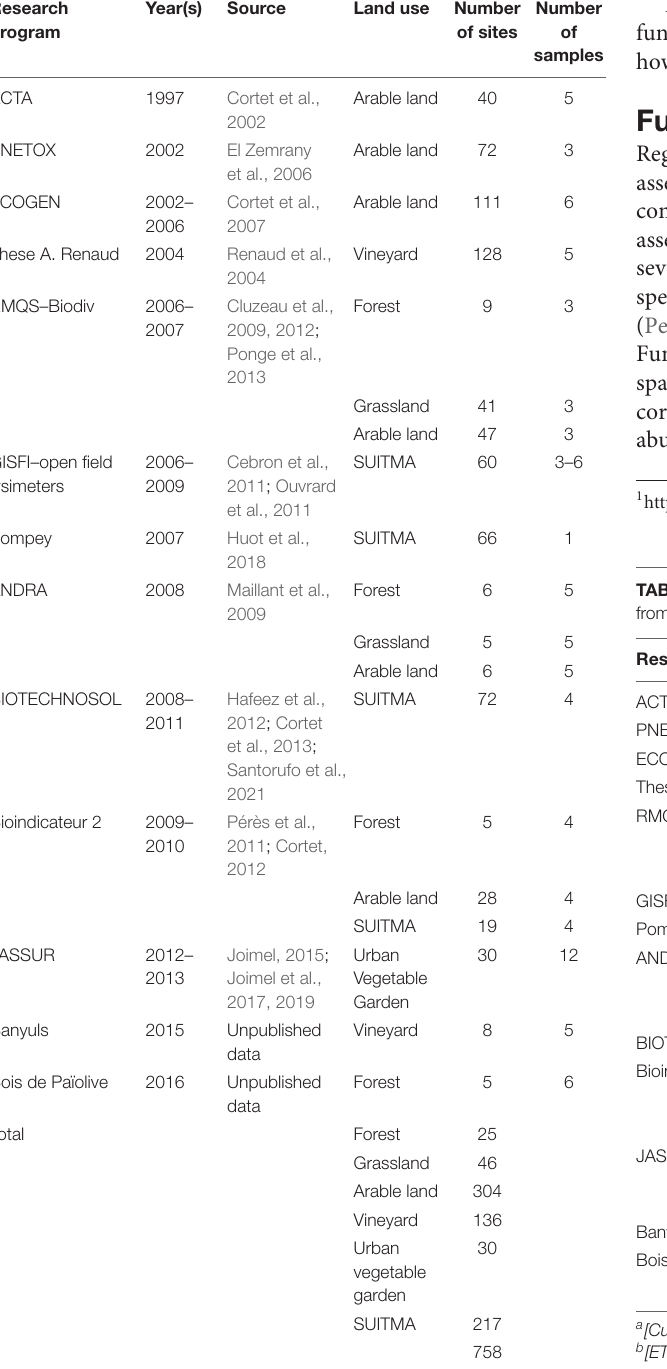
TABLE 1 | Main features of Collembola samples collected from 13 research programs.